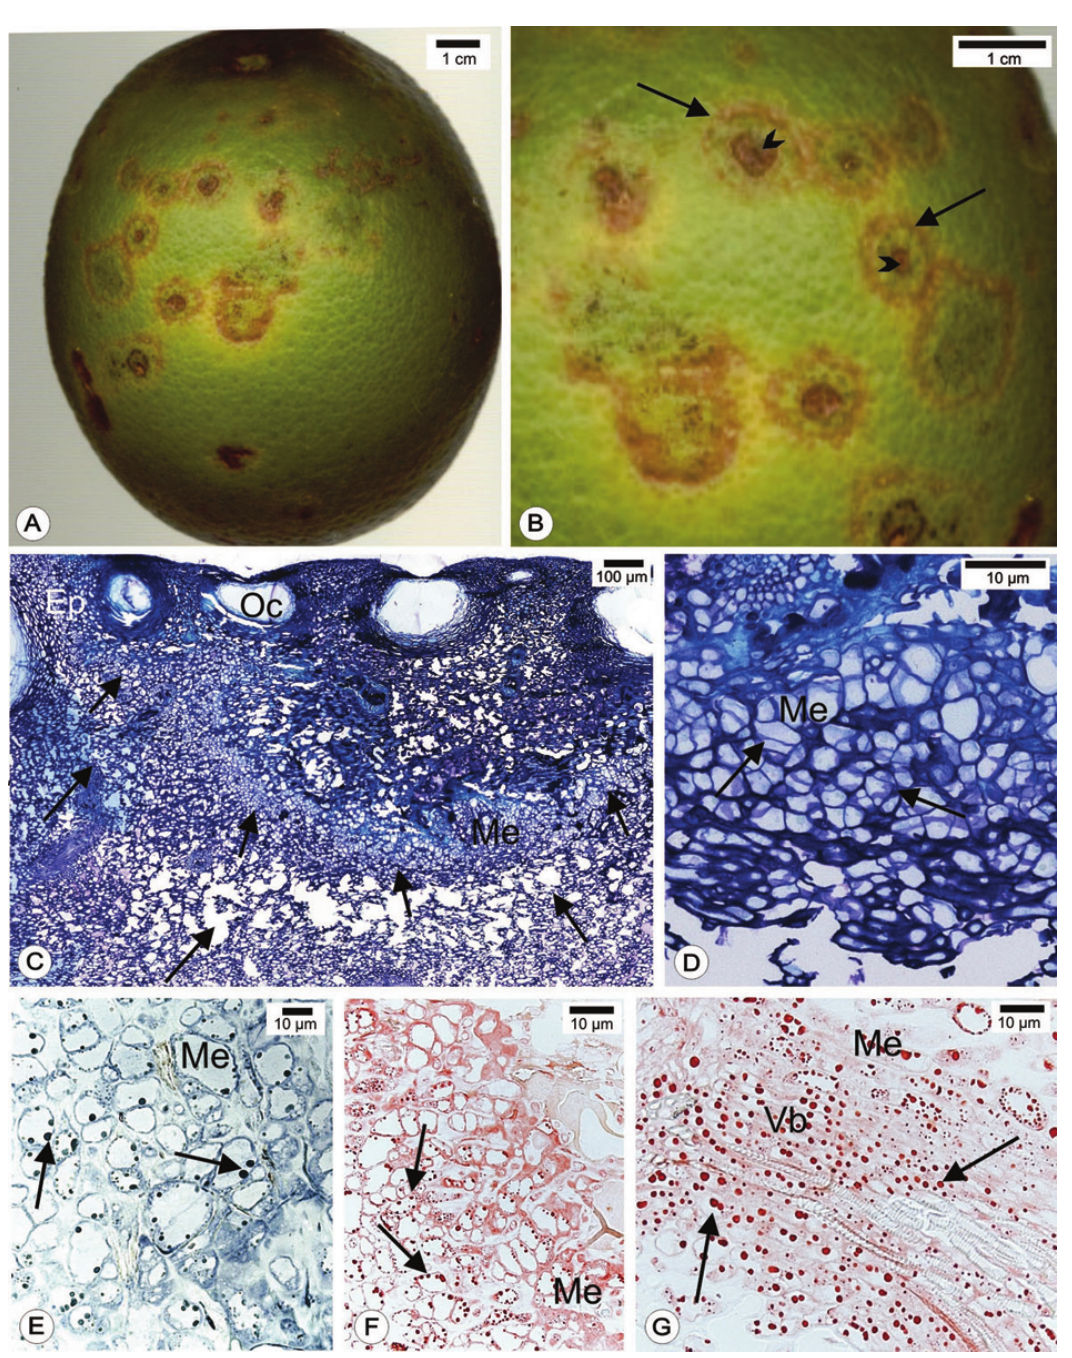
Fig. 4 – Lesions caused by CiLV-C in Citrus sinensis (L.) Osbeck ‘Pêra’ fruits. Sections stained with Sudan Black B (E) Toluidine Blue (C-D) and Xylidine Ponceau (F-G). A-B. Overview and detail of lesions in fruits. In B is verified that the lesions show necrotic halos (arrows) around the necrotic centers (arrowhead). C-J. Cross sections of the lesion. C. The oil cavities were collapsed. Lysis region (long arrows) and hyperplasia region (short arrows). D. Detail of the hyperplasia region showed in C. E. Lipid droplets (arrows). F. Details of the region with protein droplets (arrows). G. Droplets (arrows) in the vascular bundle (Vb); Ep – Epicarp; Me – Mesocarp; Oc – Oil cavity; Vb – Vascular